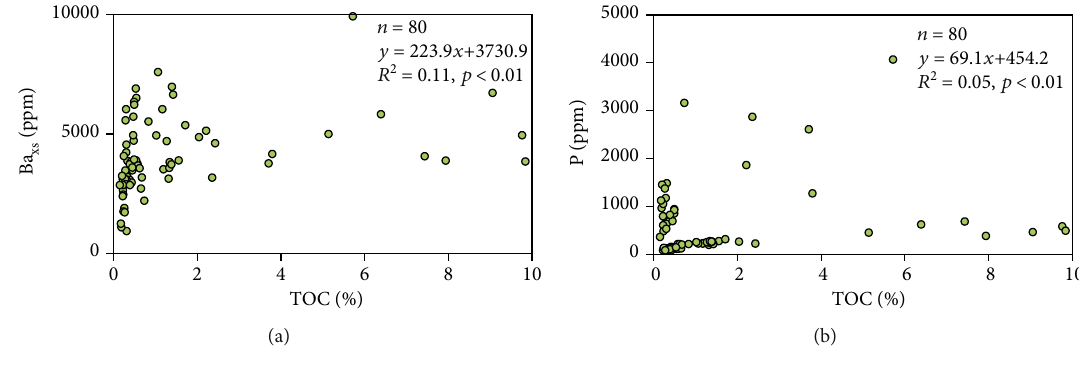
and (b) P content versus xs